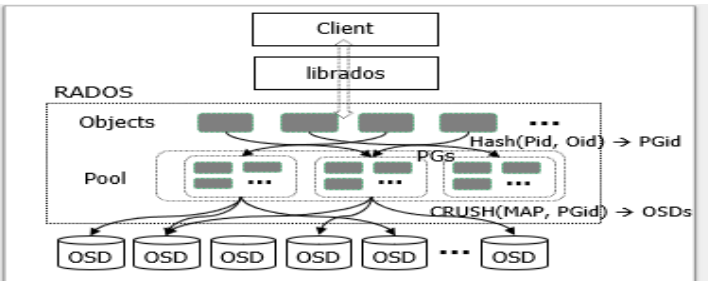
Figure 2. Mapping mechanism in Ceph: an object of a client is associated with a PG (Placement Group), and then a PG is mapped into OSDs using CRUSH (Controlled Replication Under Scal- able